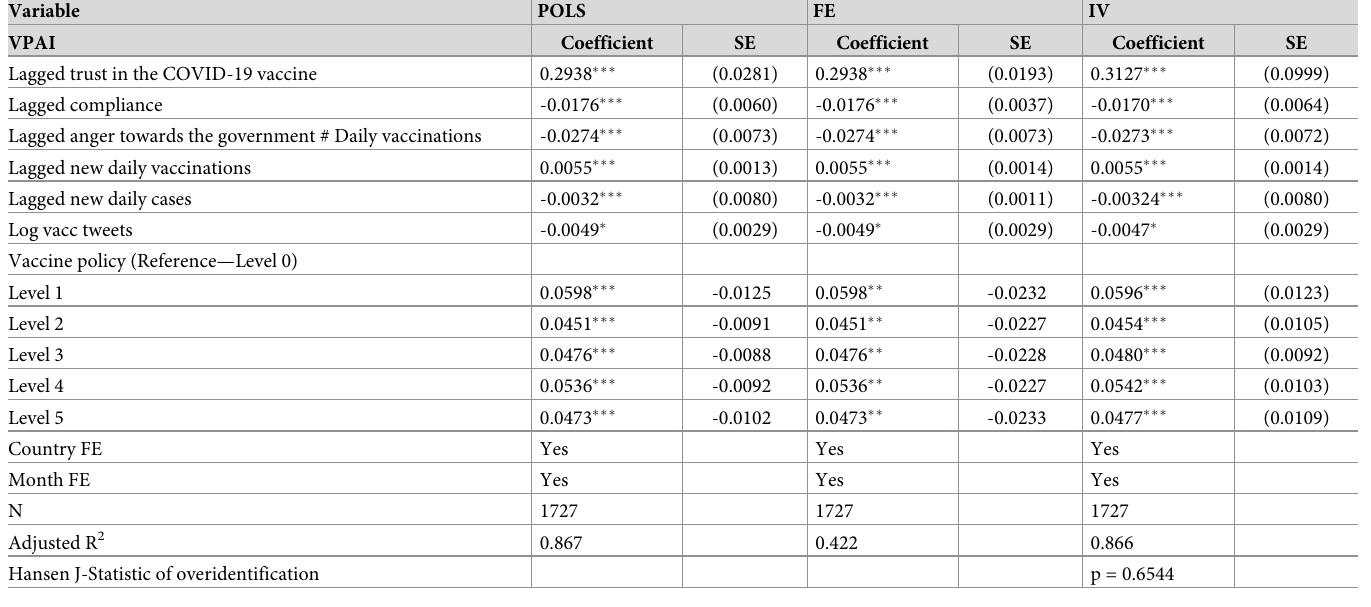
Table 3. Results from POLS with FE and